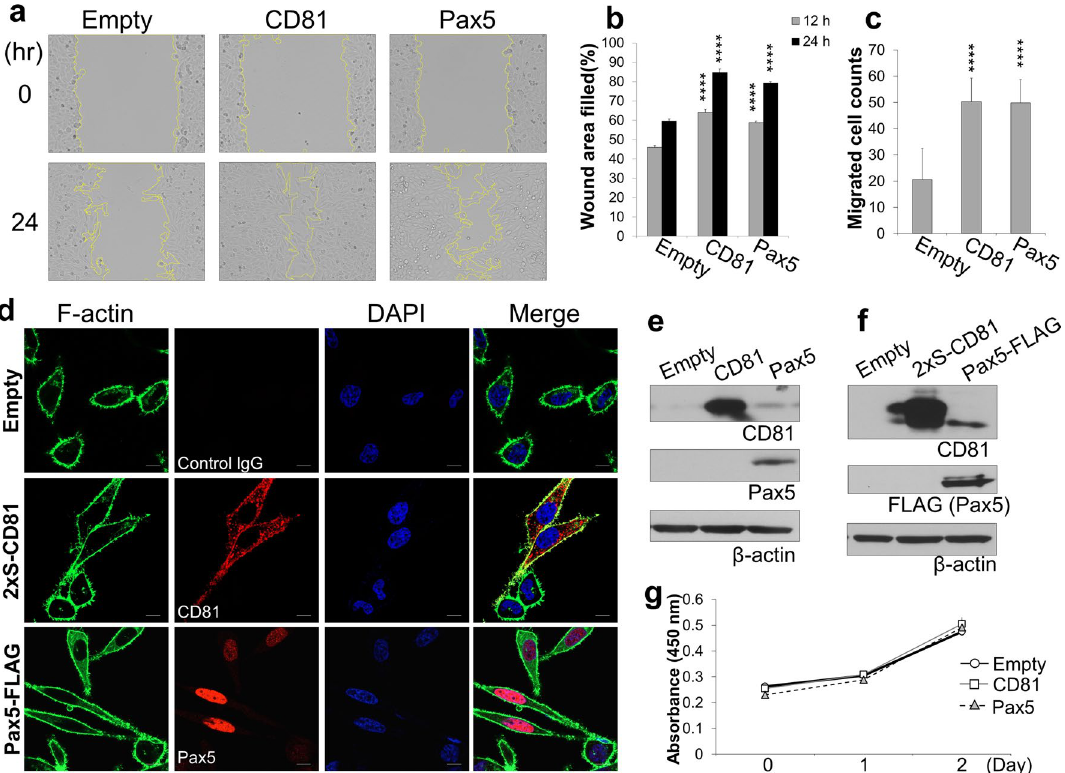
Figure 6. Pax5 expression enhances CD81-dependent functions: cell migration and membrane protrusion formation. ( a , b ) The effect of Pax5 expression on wound healing of HeLa cells on a cells sheet. HeLa cells were transfected with empty, CD81, or Pax5 plasmids and cultured for 12 h. The confluent cell sheet was scratched with a P2 micro-pipette tip, and this timing was defined as 0 h. The wound healing area was enclosed with a yellow line and measured using ImageJ. Left pictures are representative images of the wound healing assay at 0 and 24 h. ( b ) The graph shows the quantitative data of the wound healing filled area. The area was defined as 100% when all the scratches are filled, i.e., the wound area at 0 h was defined as 100% in each cell group. Wound area filled (%) = (mean of first wound area—mean of last wound area)/first wound area × 100. The gray and black bars show the wound area filled at 12 and 24 h, respectively. ( c ) Evaluation of cell migration activity in Pax5-transfected cells by a transwell migration assay without matrigel. HeLa cells were transfected with empty, CD81, or Pax5 plasmids and cultured for 24 h. Transfected cells were seeded in the top chamber of the transwell insert. The top and bottom chambers were filled with culture medium in 10% FBS. Cells were